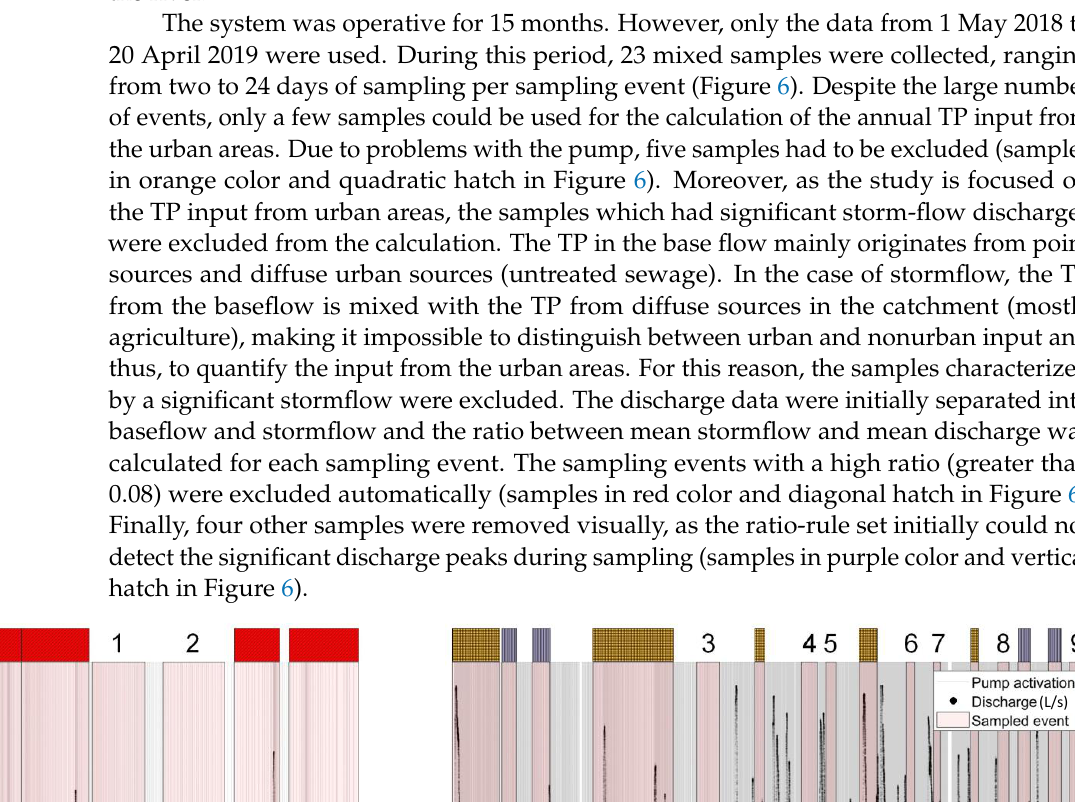
Figure 7. Time periods with a cumulative baseflow volume of 280,000 m 3.